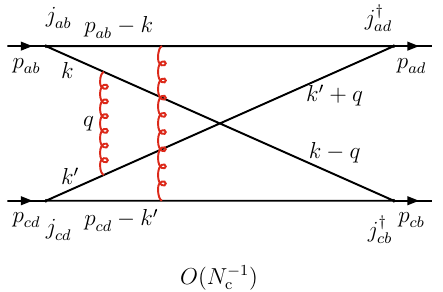
Fig. 20 One-gluon exchange between quarks a and d